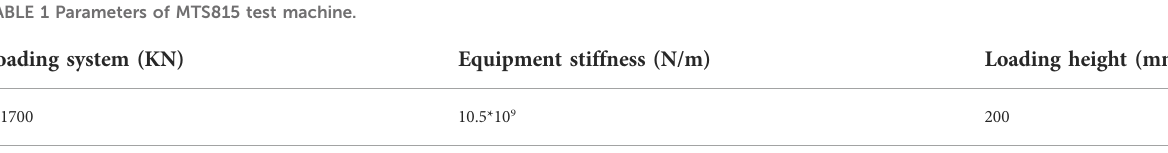
TABLE 1 Parameters of MTS815 test machine.